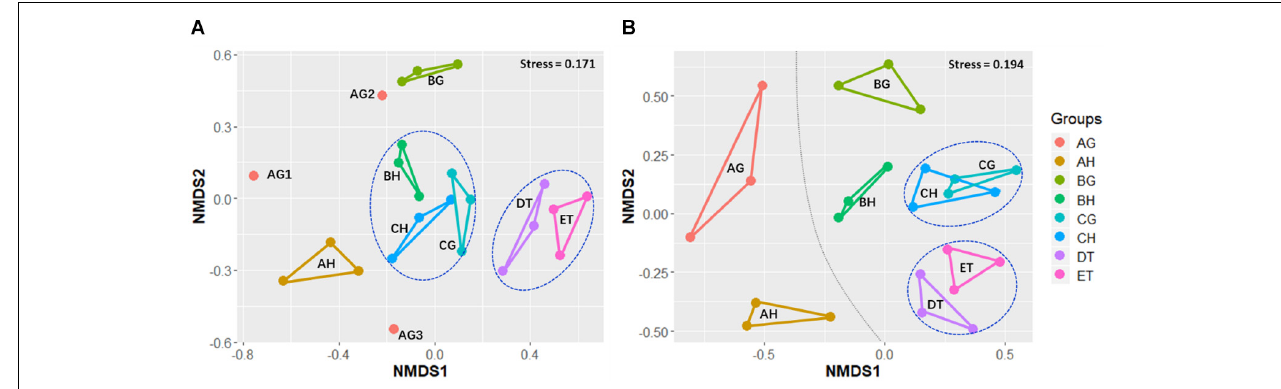
FIGURE 3 | Non-metric multidimensional scaling (NMDS) analysis of beta-diversity based on the Bray–Curtis distance matrix for bacterial (A) and fungal (B) communities of all samples, with the stress of 0.171 and 0.194, respectively. AH and AG, hemolymph and gut of uninjected living larvae; BH and BG, hemolymph and gut of living larvae with high blastospore load; CH and CG, freshly mummifying larvae without mycelia coating; DT, tissues of the mummified larvae coated with mycelia; ET, tissues of the completely mummified larvae with mycelia.